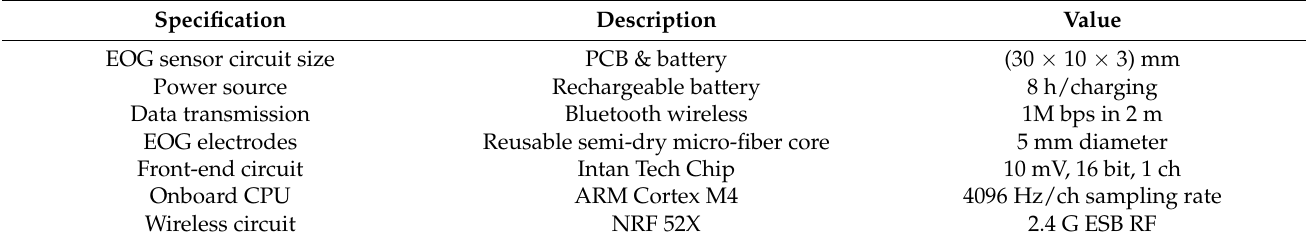
Figure 4. Overall system block diagram of the wireless EOG device. Table 3. The specifications of the wireless wearable EOG